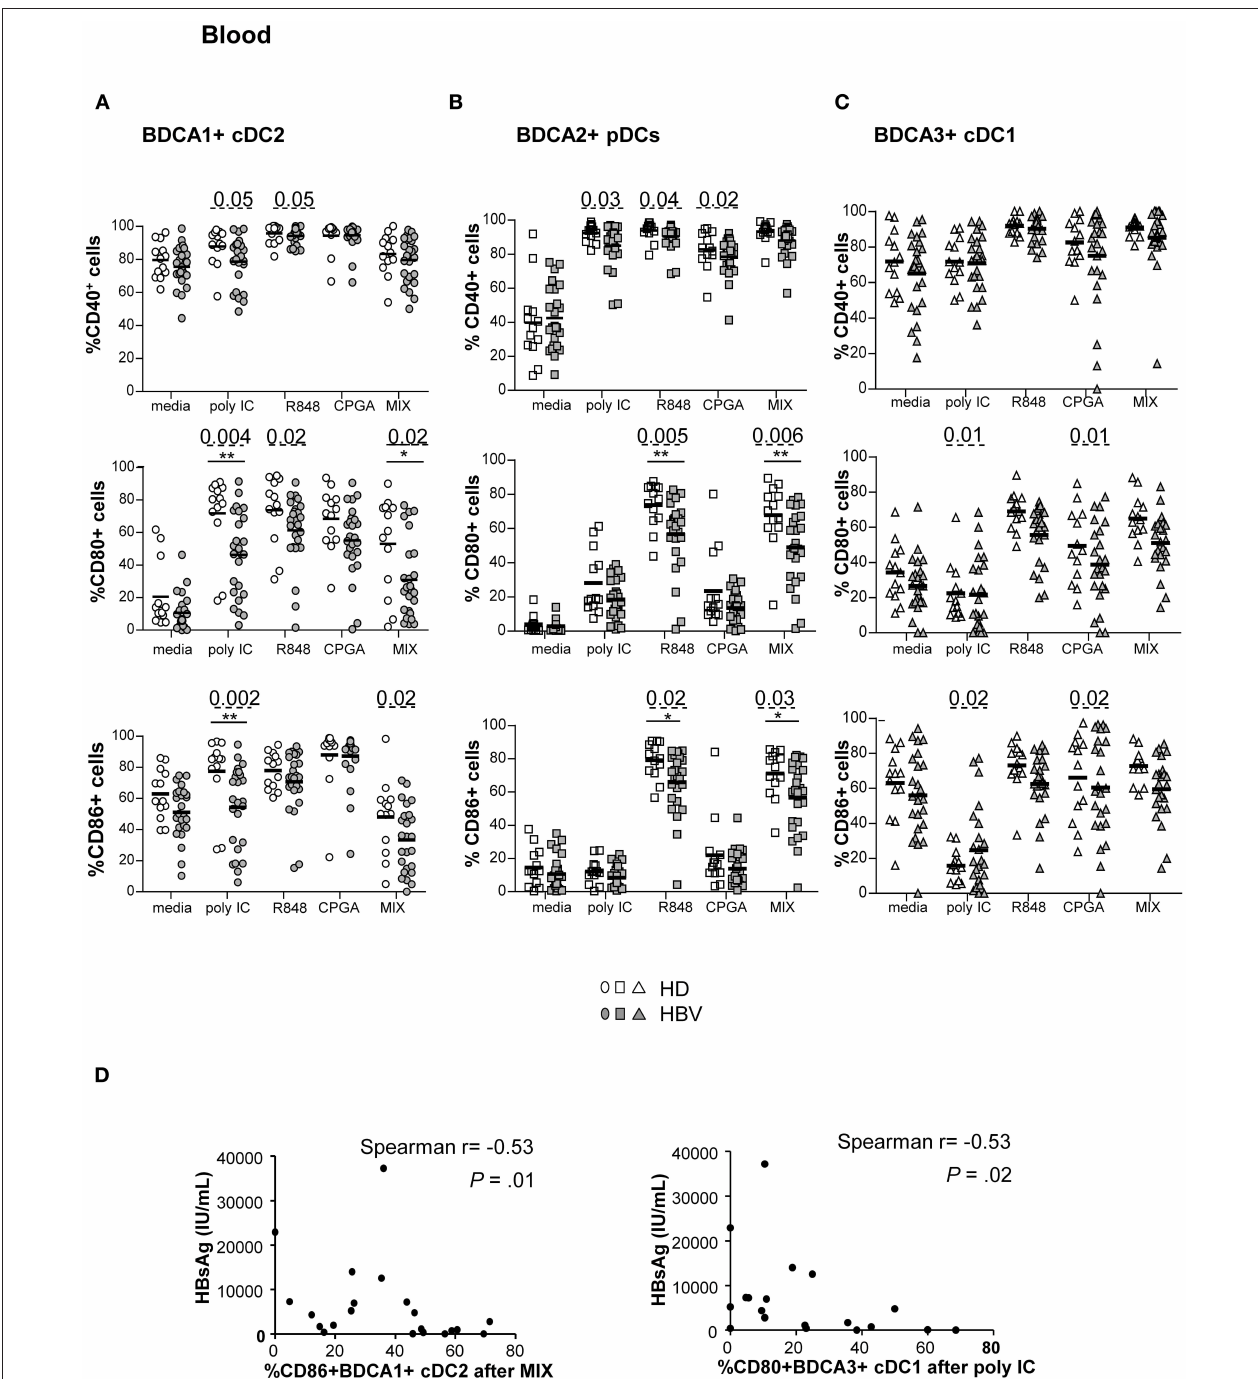
FIGURE 4 | Defective maturation of circulating BDCA1 + cDC2, BDCA2 + pDCs, and BDCA3 + cDC1 from chronic HBV patients upon TLR triggering. PBMCs from HD or HBV patients were stimulated for 22h with or without TLRLs (polyI:C, R848 or CPG A (ODN2336)) alone or mixed together (MIX:polyI:C + R848 + CPG A ) and the expression of the maturation markers was measured by flow cytometry. Percentages of CD40, CD80, and CD86 molecules on (A) cDC2, (B) pDCs, and (C) cDC1. Open symbols, HD ( n = 13–18); filled symbols, HBV ( n = 22–26). P -values were calculated using the 2-way-RM ANOVA test (straight line) * P ≤ 0.05, ** P < 0.01 and Mann–Whitney test (dashed lines). Bar indicates mean. (D) Spearman correlations between the expression of maturation molecule on cDC2 and cDC1 from HBV patients and plasmatic HBsAg levels ( n = 19–21).